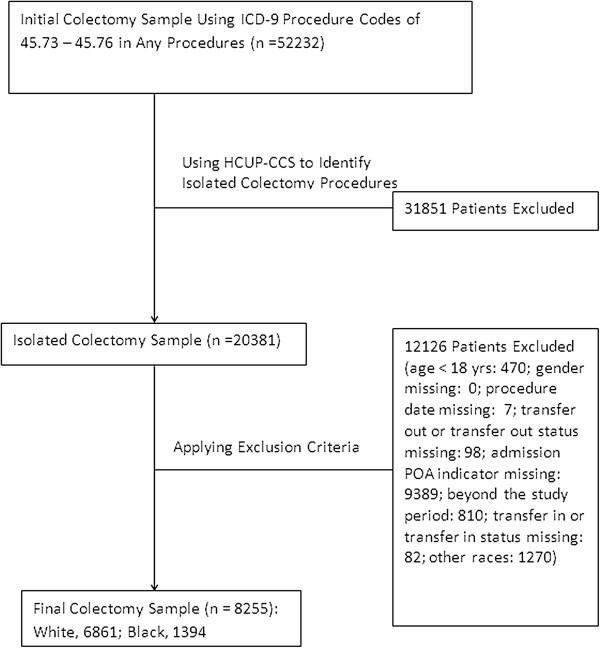
Flow chart for colectomy sampling.